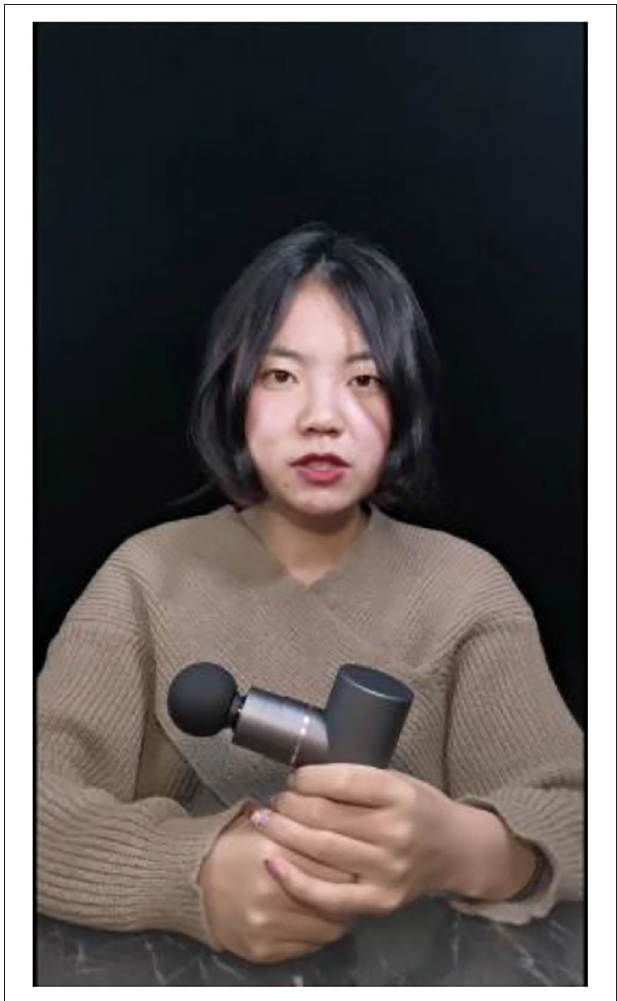
FIGURE 3 | A2 Screenshot of low social